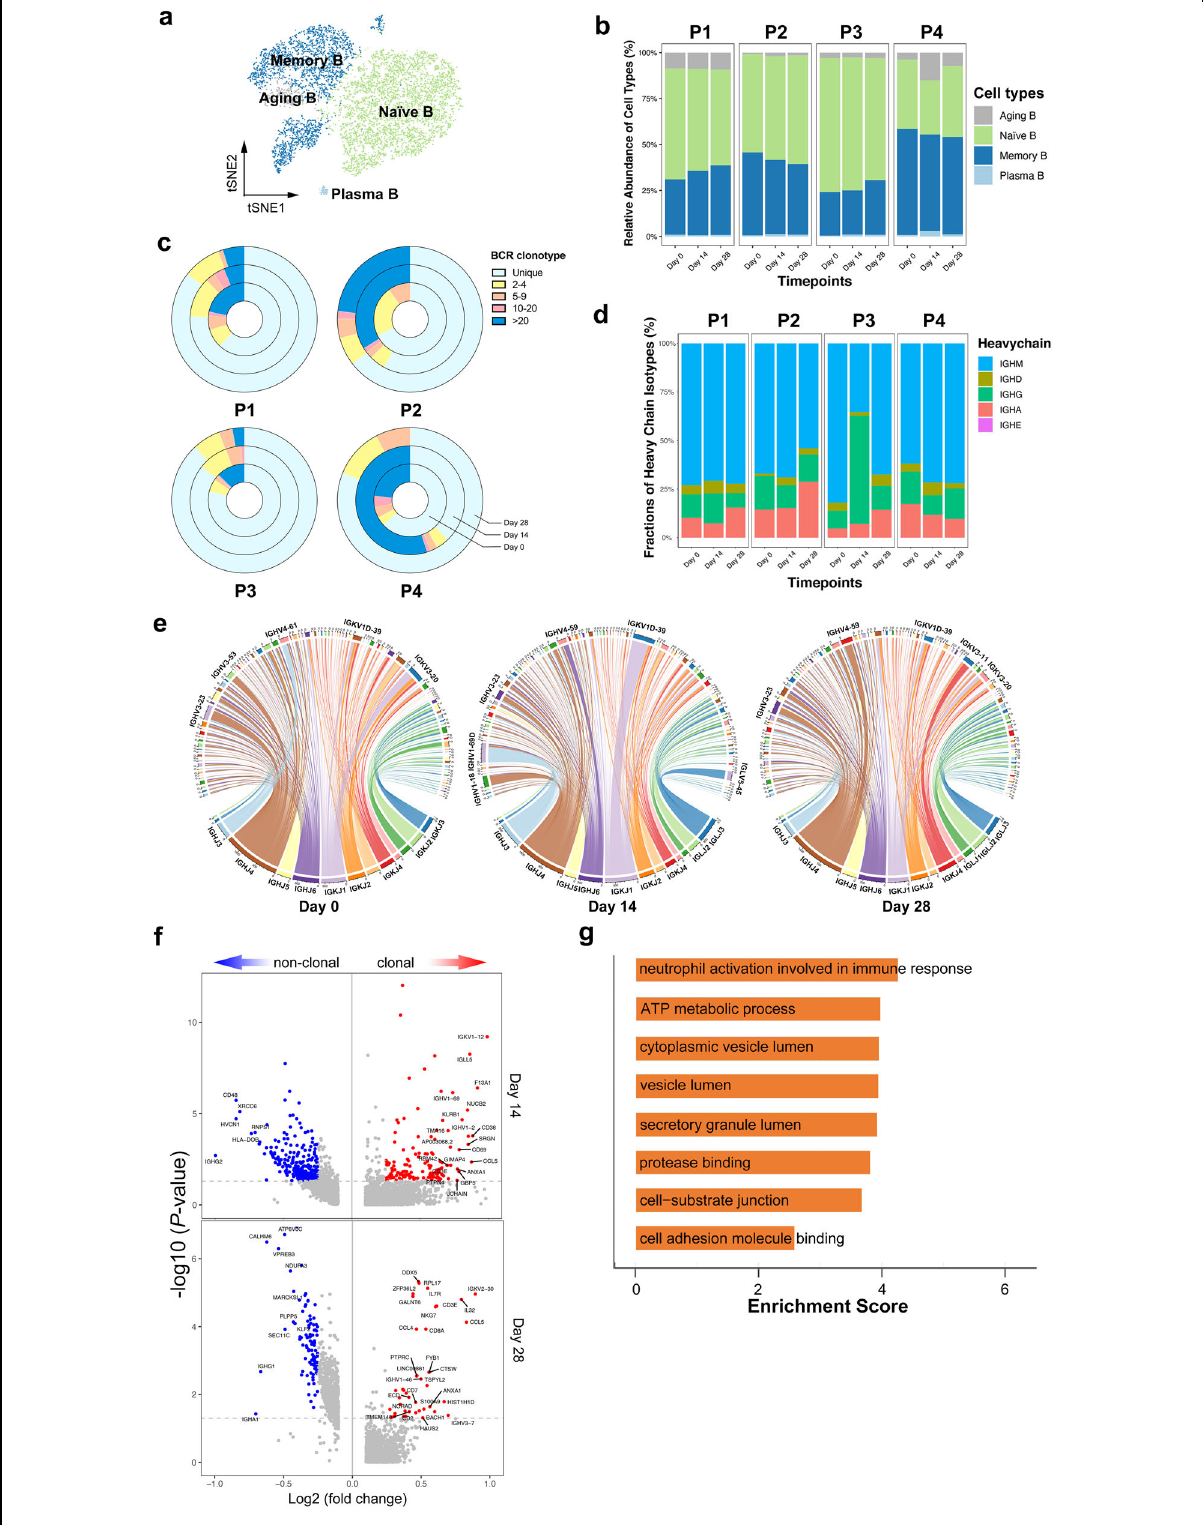
Fig. 2 (See legend on next